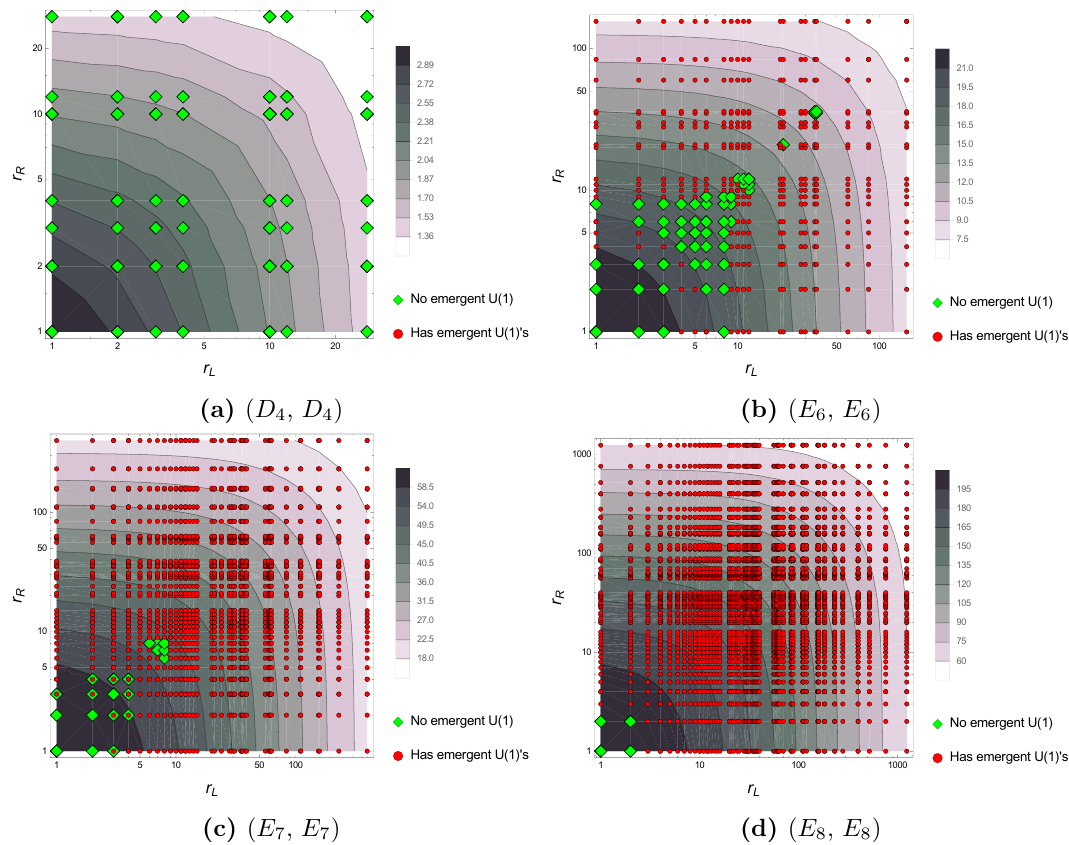
Figure 8. Plots of a IR vs left and right embedding indices for the di(cid:11)erent plain mass nilpotent deformations of 4D conformal matter theories. The contour plots are obtained by extrapolating between the actual data points which are labelled in green diamonds and red circles. The green diamonds correspond to deformations where all operators remain above the unitarity bound and no emergent U(1) appears. The red circles correspond to deformations where some operators hit the unitarity bound and emergent U(1)’s are present. We emphasize that sometimes di(cid:11)erent nilpotent orbits can have the same embedding index. A log-scale is used to spread the dense region at low values of the embedding